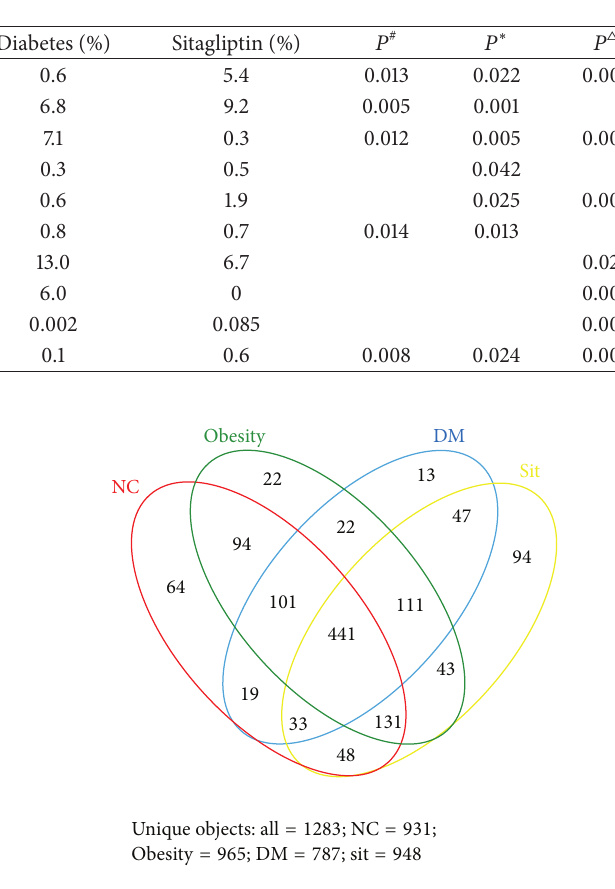
Figure 3: Shared OTU analysis of the different conditions. Venn diagram showing the unique and shared OTUs (3% distance level) in the different